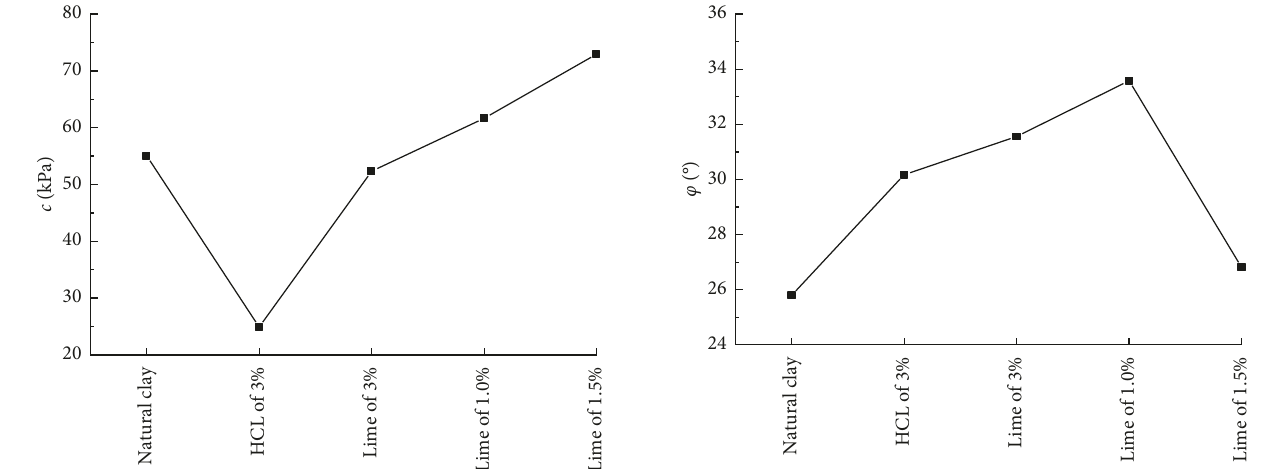
Figure 10: Variation in cohesion of lime-cured acid-contaminated clay.